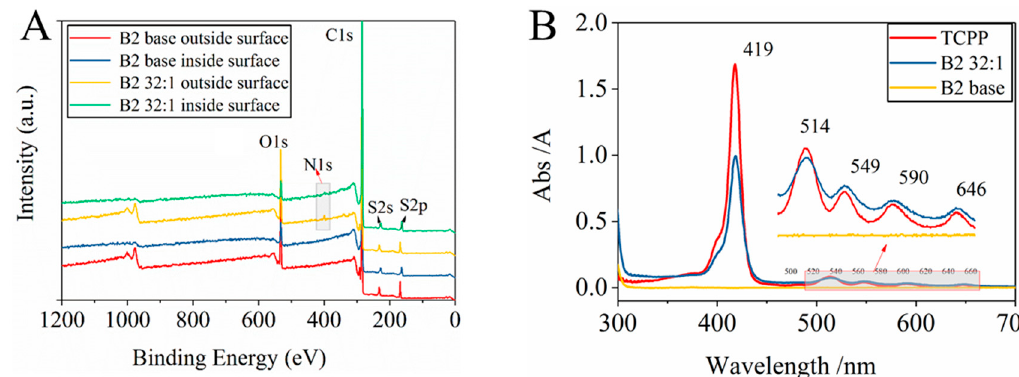
Figure 3. Characterization of TCPP in the membrane. ( A ) XPS spectra of B2 Base and B2 32:1 membrane, ( B ) UV spectra of as-prepared TCPP, B2 Base and B2 32:1 membrane. Table 3. Elemental percentage of B2 base and B2 32:1 membranes obtained from XPS spectra. Membrane